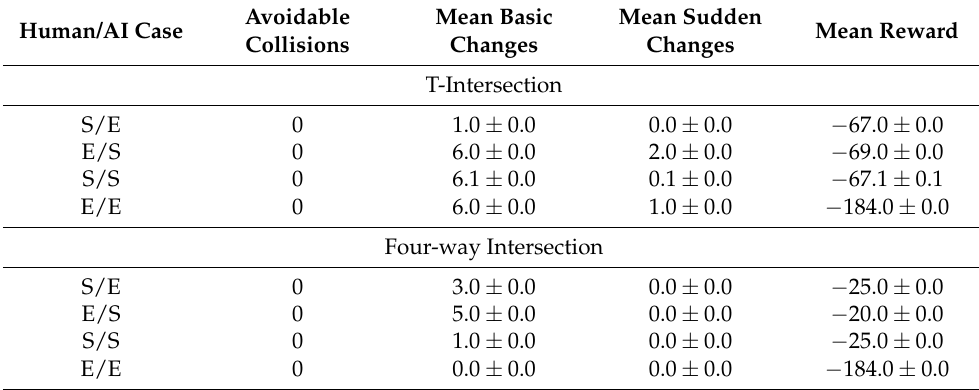
Table 9. Human: sensor and mask, AI: sensor and mask. Test results for manager performance and behavior.